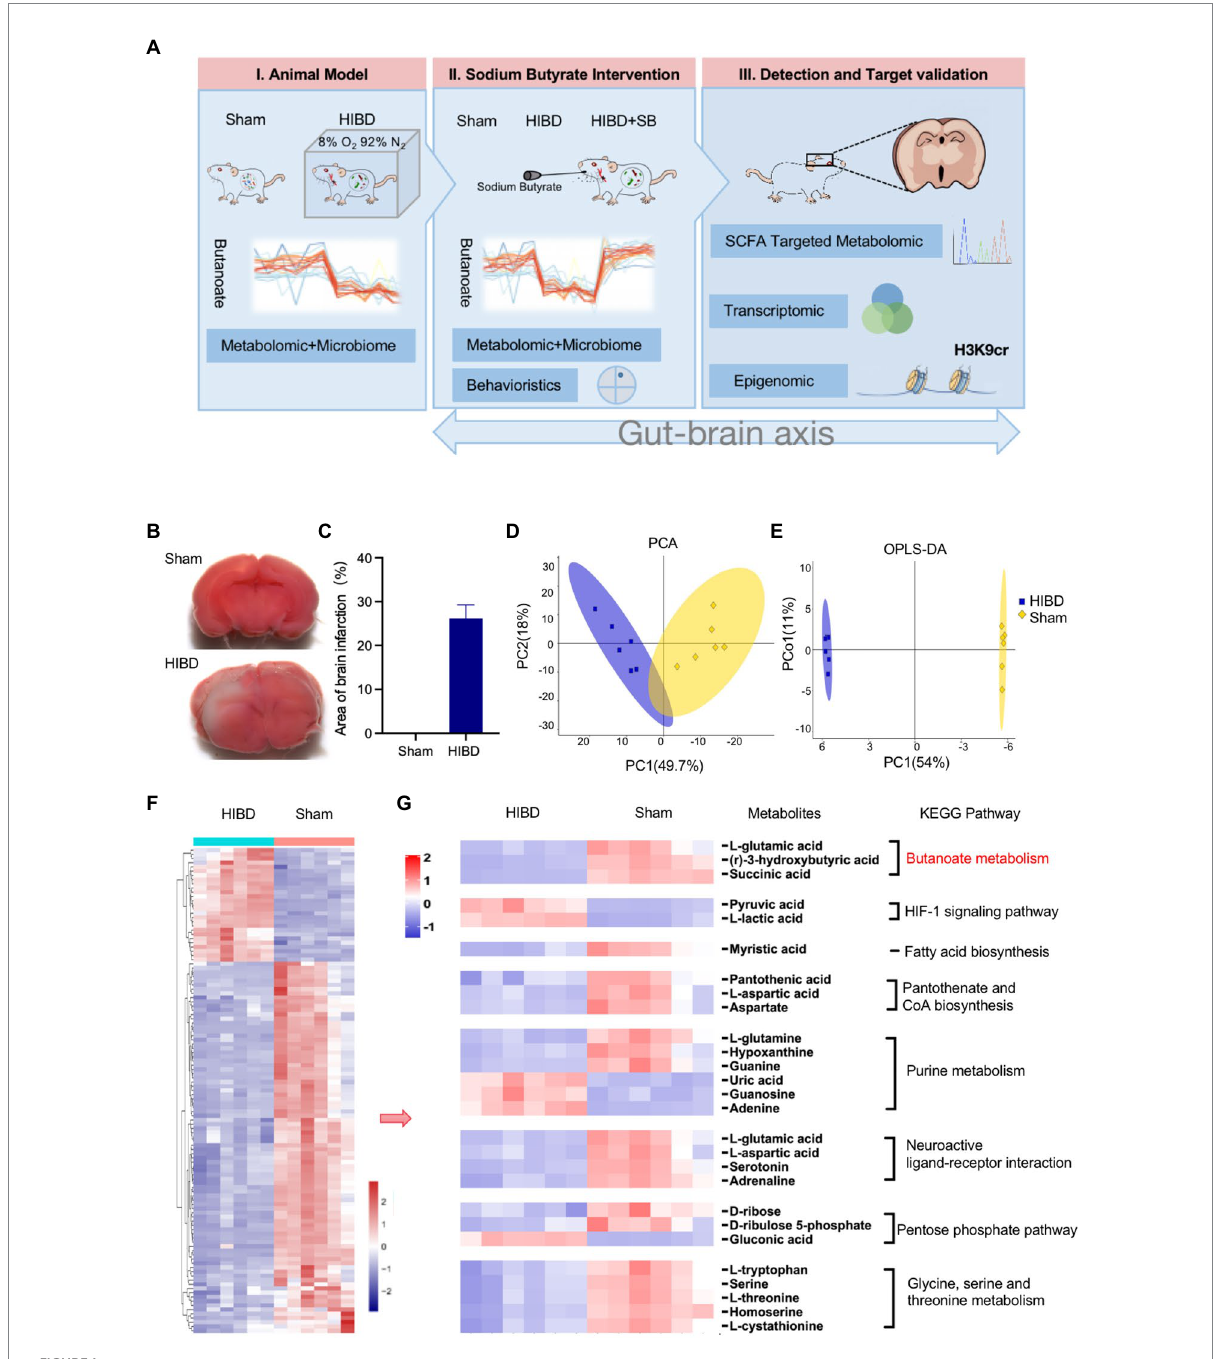
FIGURE 1 ( A ) Experimental flow chart depicting this study. Sham “sham operated group”, HIBD “hypoxic–ischemic brain damage group,” HIBD + SB “sodium butyrate (SB) treatment group.” ( B,C ) TCC staining detection and Image J quantification of the area of brain infarction, n = 3, error bars represent SD. ( D,E ) PCA analysis to the overall distribution and stability of each sample, and (O)PLS-DA to distinguish the global metabolic differences between groups and identify the differential metabolites between Sham and HIBD group ( n = 6). ( F ) Heat map of all differential metabolites between the Sham and HIBD group ( n = 6, all p < 0.05). ( G ) Representative differential metabolites in the Sham and HIBD group were screened out, the KEGG terms shown on the right side ( n = 6, all p <